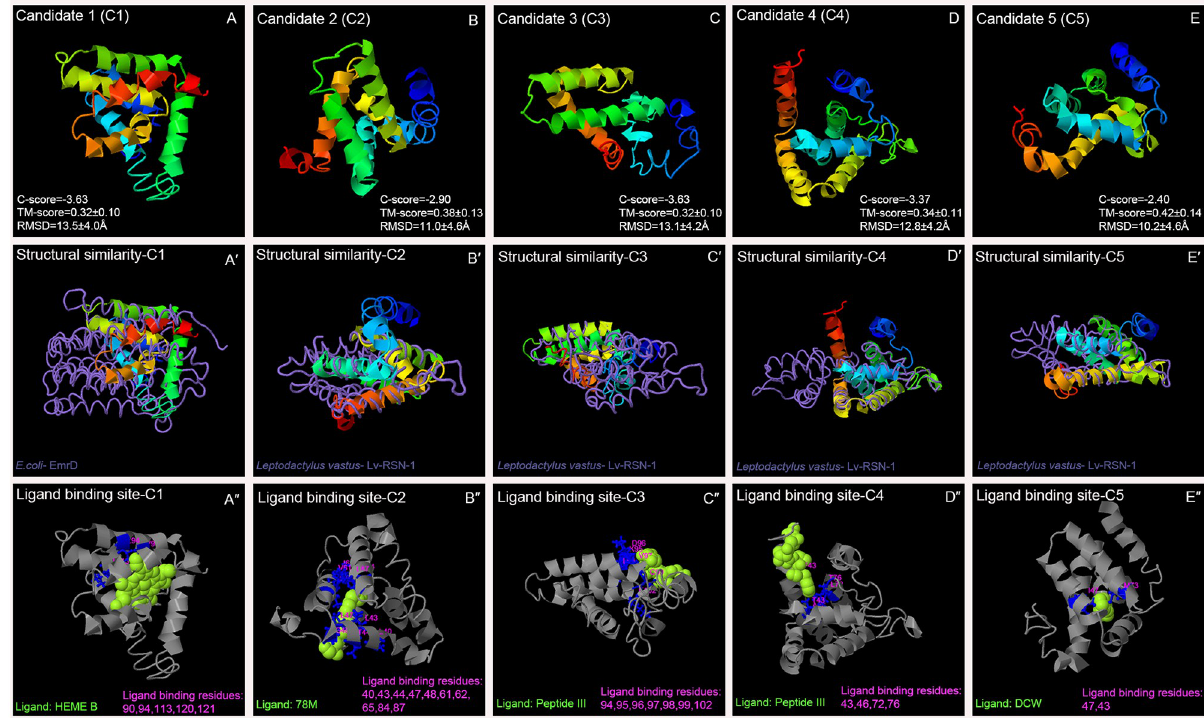
Fig 1. Three-dimensional structure of novel Newt proteins and their predicted function. Using I-TASSER server (A-E) Three-dimensional structure of novel Newt proteins (A’-E’) Structural similarity to already submitted proteins from PDB library (Query structure is shown in the cartoon, while the structural analog is displayed using backbone trace), and (A’’-E’’) ligand that has highest probability to bind to the ligand site in the protein are predicted.